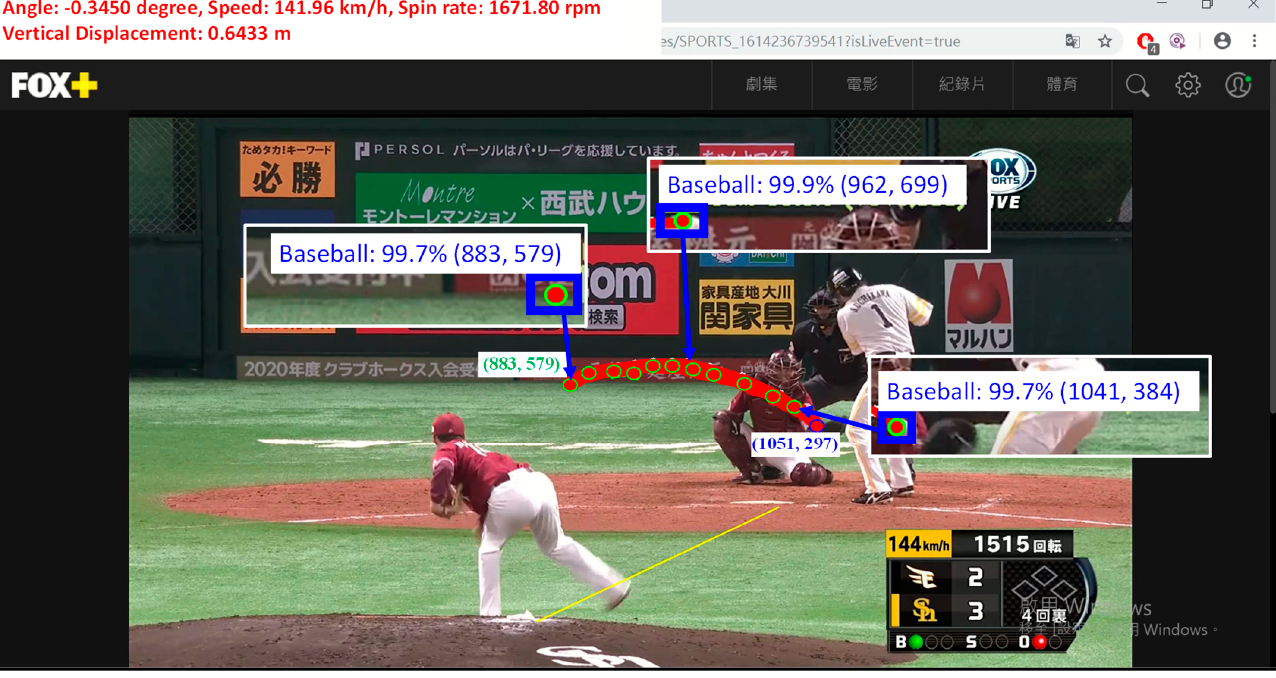
Figure 9. Automatic measurement result for a forkball.